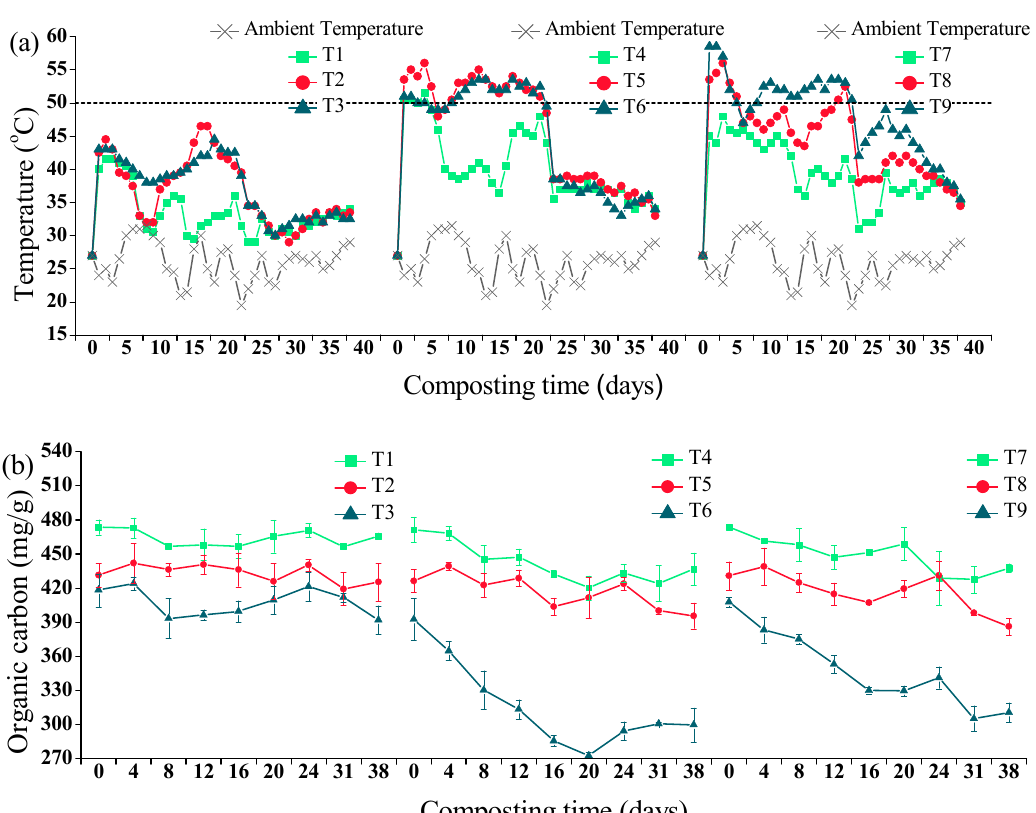
Figure 1. Variation in composting temperature ( a ) and organic carbon content ( b ) during the composting process. Treatments T1–T9 are described in Table 1. The part above the dotted line in ( a ) represents the time of the thermophilic period during composting.